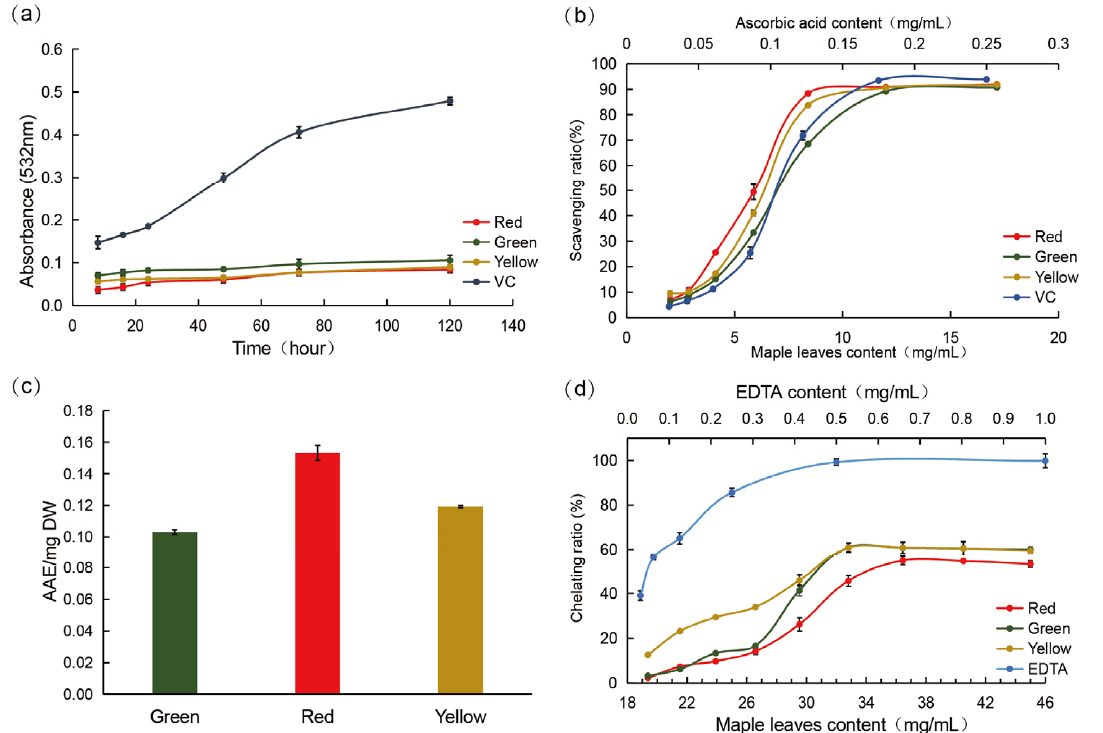
Figure 2. In vitro antioxidant properties of maple leaves of different colors. ( a ) Dose-dependent TBARS absorbance values of maple leaves of different colors; ( b ) Dose-dependent DPPH scavenging ability of maple leaves of different colors and ascorbic acid; ( c ) FRAP value of maple leaves of different colors; ( d ) Dose-dependent metal ions chelation capability of maple leaves of different colors and EDTA. AAE, ascorbic acid equivalents; DW, dry weight.